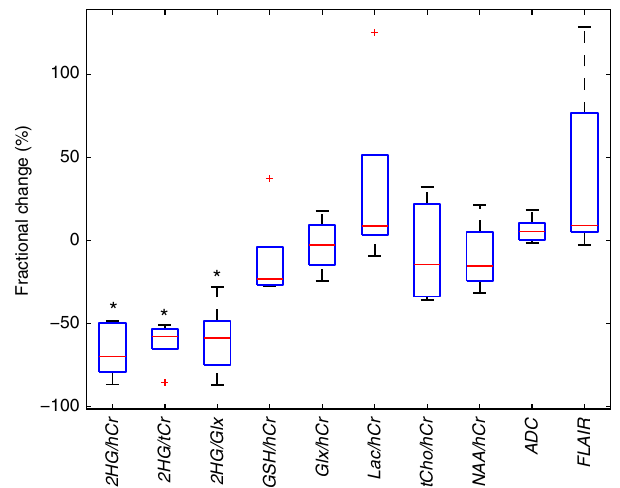
Fig. 3 Boxplot of the fractional changes for the mean values averaged over the tumor ROI. Box size represents the fi rst and third quartiles, and horizontal red line indicates the median. Statistical signi fi cant changes are indicated by the * symbol ( P <